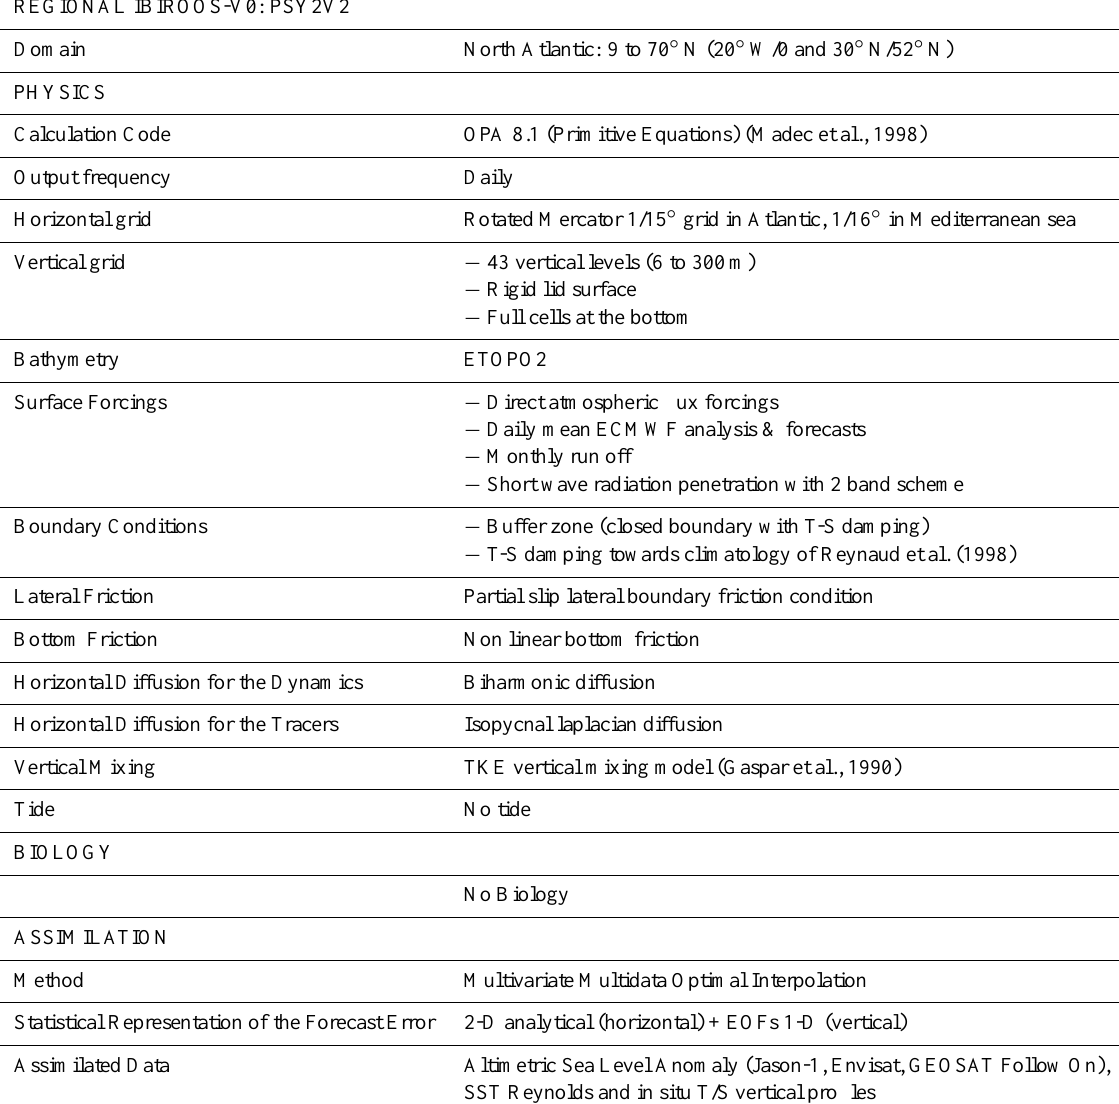
Table 1. Description of regional IBIROOS-V0: PSY2V2. REGIONAL IBIROOS-V0: